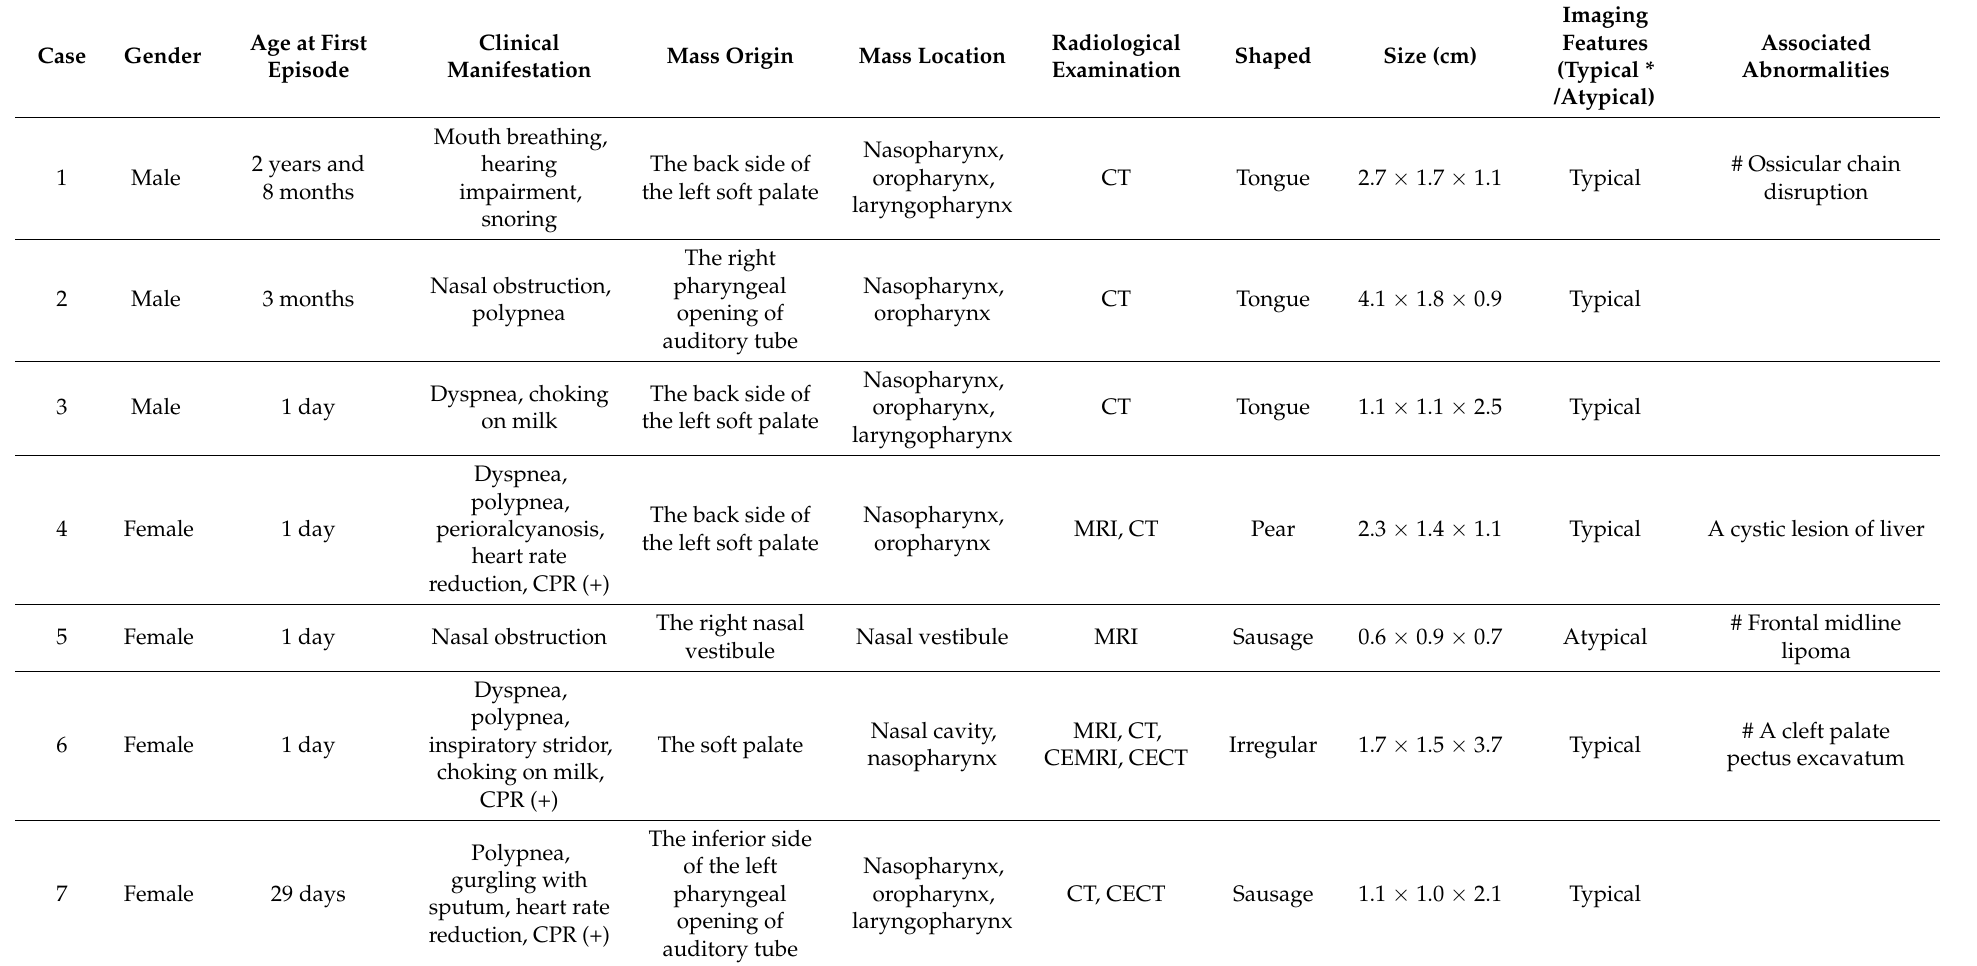
Table 1. Clinical and imaging features of patients with hairy